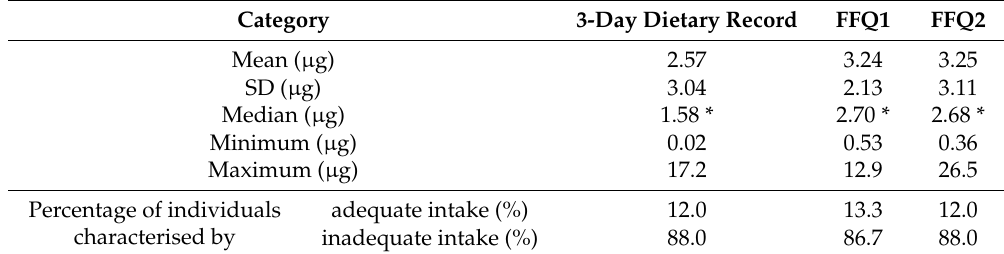
characterised by